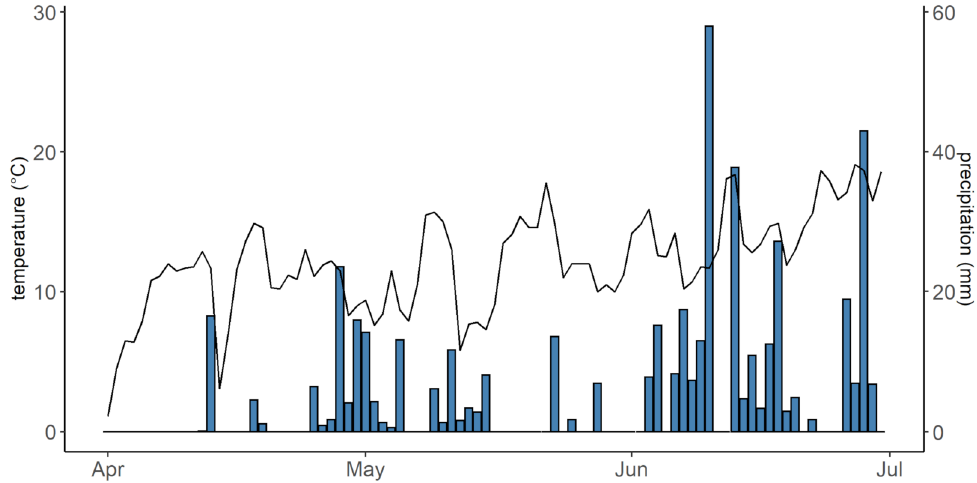
Figure 3. Daily meteorological data recorded at DWD station ‘Garmisch-Partenkirchen’ between 1 April and 30 June 2020 (solid black line—temperature, blue bars—precipitation). Data: DWD